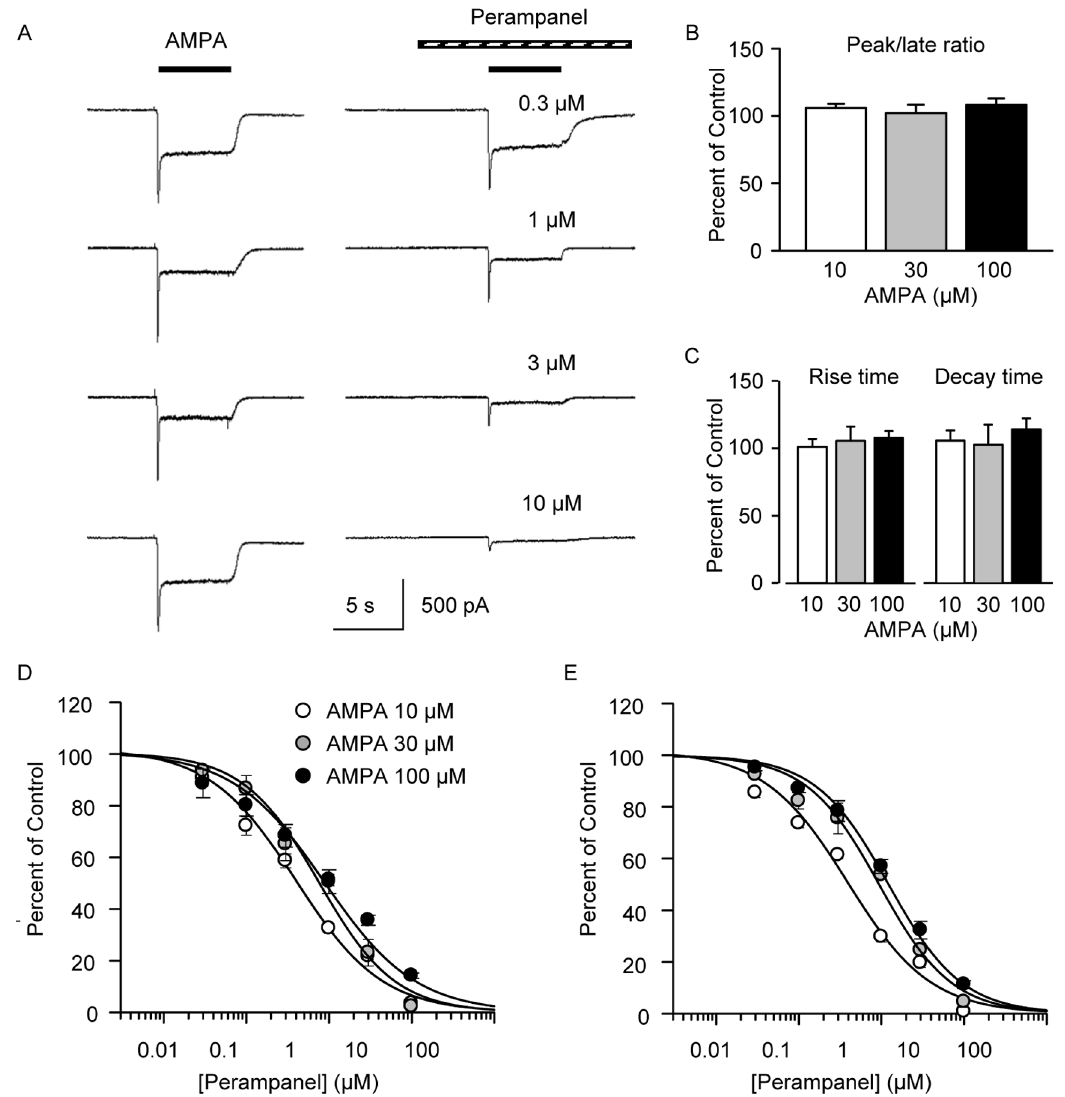
Figure 1. Perampanel inhibition of AMPA-evoked currents in cultured hippocampal neurons. (A) Sample currents evoked by 100 m M AMPA in 4 neurons in the absence ( left panels ) and presence ( right panels ) of perampanel at the concentrations indicated demonstrating a concentration-dependent reduction in current. (B) Perampanel (1 m M) did not alter the mean values of the ratio of the peak to the late amplitude of currents evoked by 10, 30 and 100 m M AMPA in 7, 8 and 7 neurons, respectively, and (C) did not affect the mean rise time constant values or mean decay time constant values of the currents. Peak (D) and late (E) current values evoked by various AMPA concentrations expressed as percent of control prior to perampanel. Curves represent logistic fits to the data for each AMPA concentration. Peak current is the maximum current level; late current is the current during the last 100 ms of the perfusion. Data points in D and E represent mean 6 S.E.M. of values from 3 to 9 neurons. Control values for peak/late ratio: 10 m M AMPA: 1.5 6 0.1; 30 m M AMPA: 1.7 6 0.1; 100 m M AMPA: 2.7 6 0.3. Control values for decay time constant (ms): 10 m M AMPA: 141 6 13; 30 m M AMPA: 93 6 7; 100 m M AMPA: 50 6 2. Control values for rise time (ms): 10 m M AMPA: 51 6 2; 30 m M AMPA: 45 6 3; 100 m M AMPA: 32 6